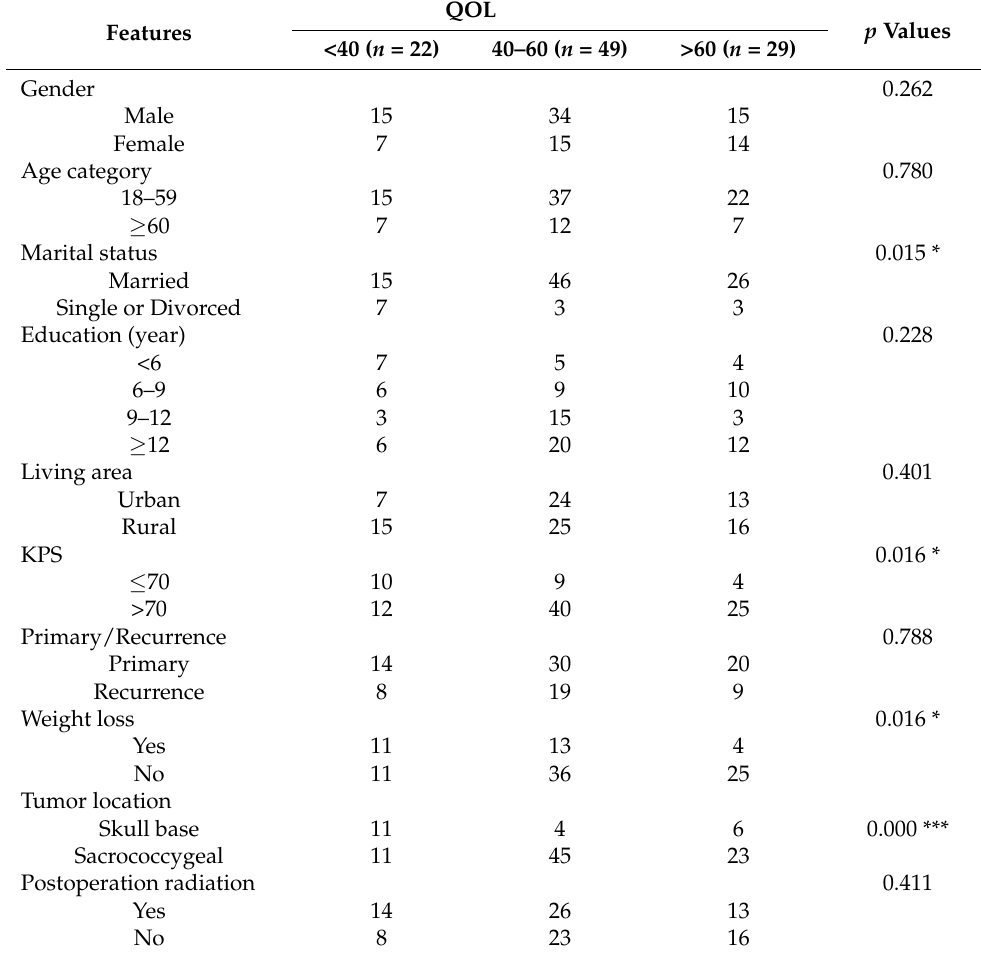
Table 4. Associations between patient characteristics and